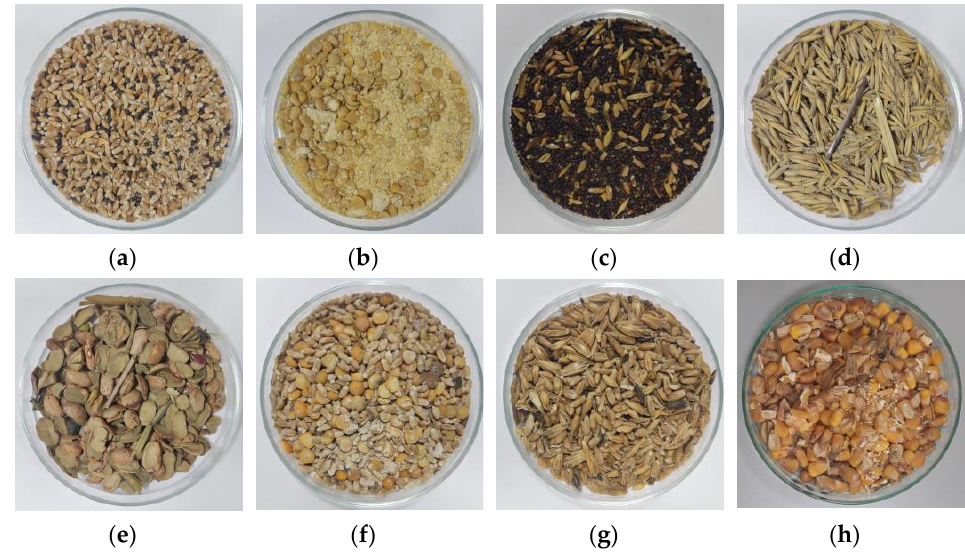
Figure 1. SPWs samples: ( a ) wheat; ( b ) soybean; ( c ) rapeseed; ( d ) oats; ( e ) beans; ( f ) peas; ( g ) barley; ( h ) corn.